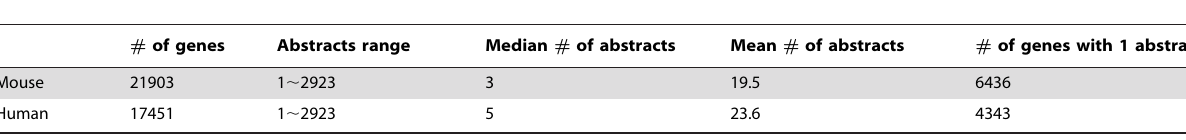
Table 1. Summary of mouse and human gene document